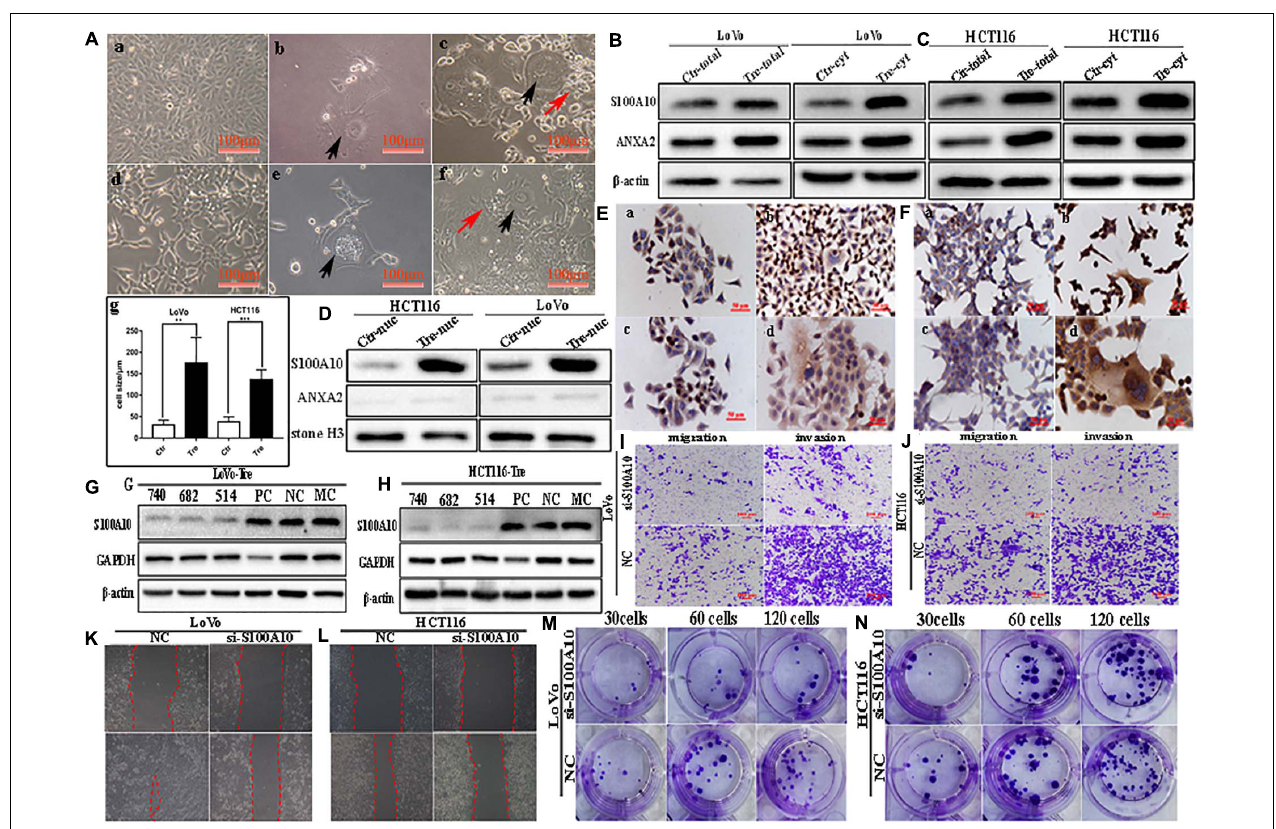
FIGURE 1 | S100A10 and ANXA2 expression in LoVo and HCT116 cells before and after CoCl 2 treatment. (A) Control cells and PGCCs with daughter cells derived from LoVo and HCT116 (100 × ). (a) LoVo control cells. (b) LoVo PGCCs from CoCl 2 recovered from CoCl 2 treatment and began to produce daughter cells. (c) LoVo PGCCs and daughter cells. Black arrow indicates PGCC. Red arrow indicates daughter cells. (d) HCT116 control cells. (e) HCT116 PGCCs from CoCl 2 recovered from CoCl 2 treatment and began to produce daughter cells. (f) HCT116 PGCCs with daughter cells. Black arrow indicates PGCC. Red arrow indicates daughter cells. (g) Comparison of cell size between control cells and PGCCs. (B). The total and cytoplasmic S100A10 and ANXA2 expression in LoVo control cells and PGCCs with daughter cells . (C). The total and cytoplasmic S100A10 and ANXA2 expression in HCT116 control cells and PGCCs with daughter cells. (D) The nuclear S100A10 and ANXA2 expression in HCT116 and LoVo control cells and PGCCs with daughter cells . (E) ICC staining of S100A10 and ANXA2 in LoVo cells before and after CoCl 2 treatment (ICC, 400 × ). (a) S100A10 in LoVo control cells (b) S100A10 in LoVo PGCCs with their daughter cells. (c) ANXA2 in LoVo control cells. (d) ANXA2 in LoVo PGCCs with their daughter cells. (F) ICC staining of S100A10 and ANXA2 in HCT116 cells before and after CoCl 2 treatment (ICC, 400 × ). (a) S100A10 in HCT116 control cells (b) S100A10 in HCT116 PGCCs with their daughter cells. (c) ANXA2 in HCT116 control cells. (d) ANXA2 in HCT116 PGCCs with their daughter cells. (G) Total S100A10 expression in LoVo PGCCs with their daughter cells after siRNA S100A10-740, 682, 514, siRNA control and negative control transfection. (H) Total S100A10 expression in HCT116 PGCCs with daughter cells after siRNA S100A10-740, 682, 514, siRNA control and negative control transfection. (I) The ability of migration and invasion of LoVo PGCCs with daughter cells transfected with siRNA S100A10-740 and siRNA control (100 × ). (J) The ability of migration and invasion of HCT116 PGCCs with daughter cells transfected after siRNA S100A10-740 and siRNA control (100 × ). (K) Wound-healing assay of LoVo PGCCs with daughter cells transfected with siRNA S100A10-740 and siRNA control. (L) Wound-healing assay of HCT116 PGCCs with daughter cells transfected with siRNA S100A10-740 and siRNA control. (M) Colony formation of LoVo PGCCs with daughter cells transfected with siRNA S100A10-740and siRNA control. (N) Colony formation of HCT116 PGCCs with daughter cells transfected with siRNA S100A10-740 and siRNA control. Ctr, control cells; Tre, cells treated with CoCl 2